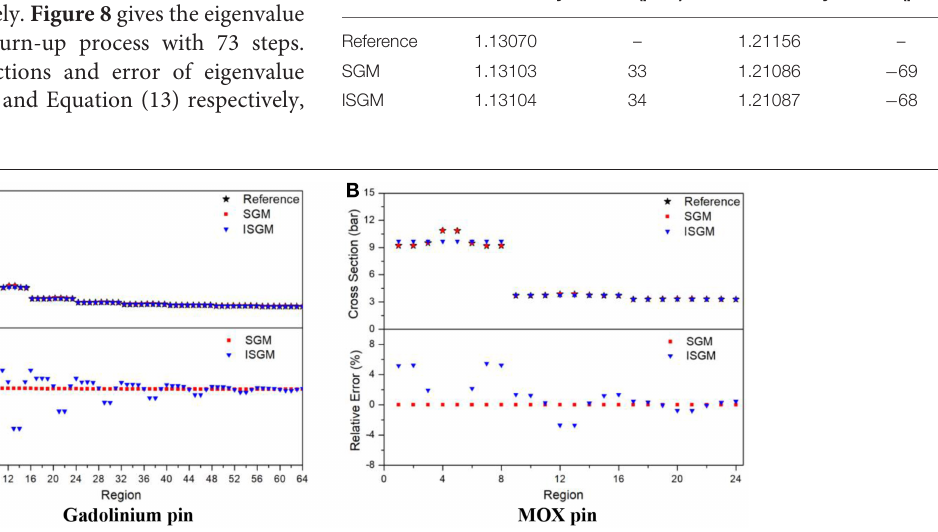
Frontiers in Energy Research |